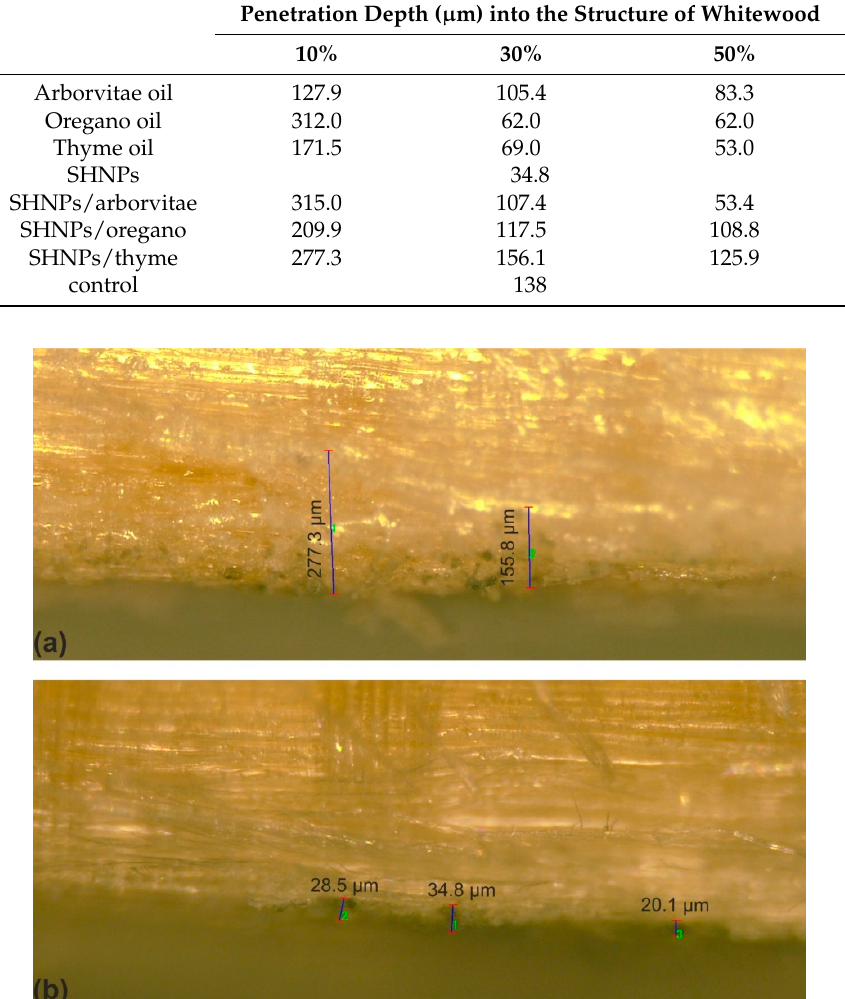
Figure 4. A. fumigatus penetration into wood structure treated with 10% of thyme and SHNPs ( a ) and SHNPs exclusively ( b ). The numbers (1, 2, 3) indicate the order of penetration depth ( µ m) into the structure of the whitewood.